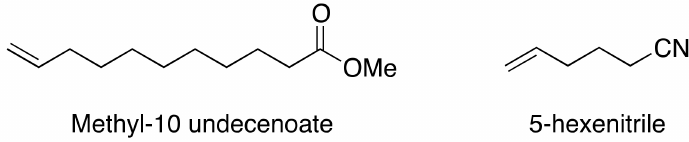
Figure 9. Methyl 10-undecenoate and 5-hexenenitrile; other substrates investigated in this